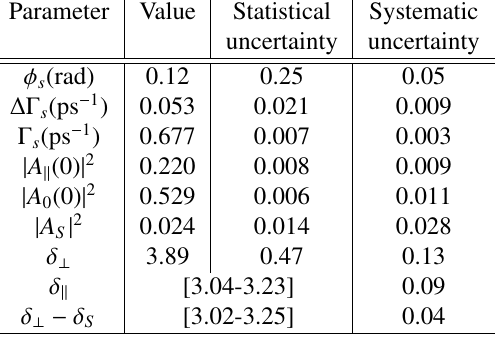
Table 2. Fitted values for the physical parameters along with their statistical and systematic uncertainties